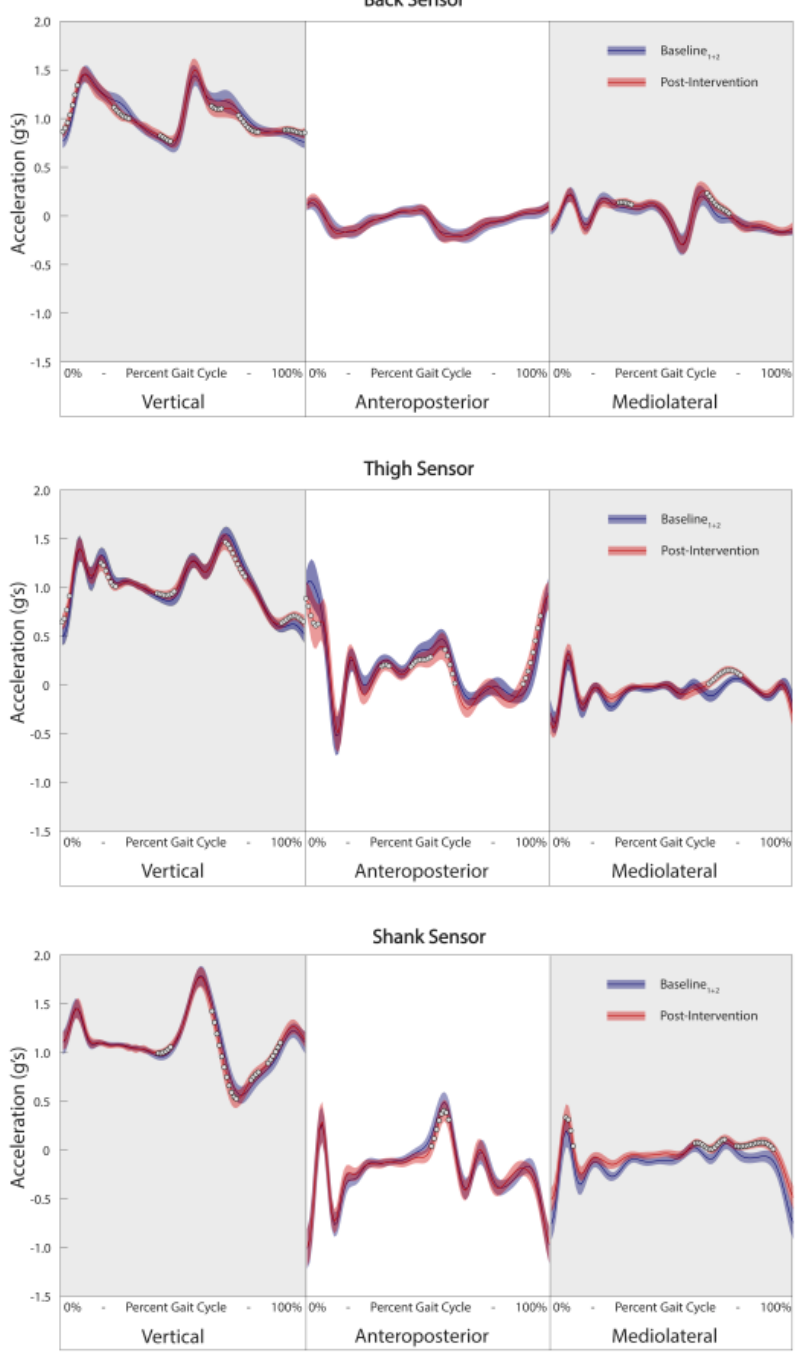
Figure 4. Example of waveform analysis of three-dimensional linear accelerations from the back ( top ), thigh ( middle ) and shank ( bottom ) visualizing changes in post-intervention data (red line) compared to baseline data (blue line). Data is presented from the patient who demonstrated the greatest number of gait cycle outliers post-intervention. White circles represent areas of the waveform where differences between baseline and post-intervention data are statistically significant (Holm-Bonferroni corrected p -value of less than 0.05) and have a large effect size (Cohen’s d > 0.8).